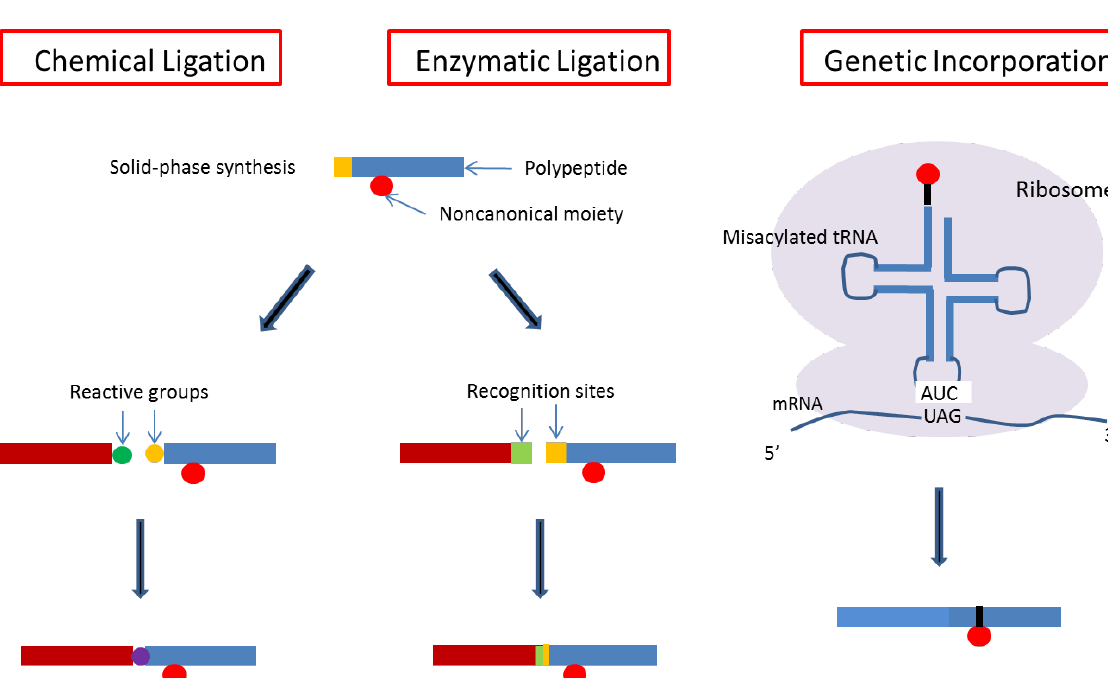
Figure 5. Methodology of bioorthogonal chemistry. Chemical ligation, enzymatic ligation, and genetic incorporation are